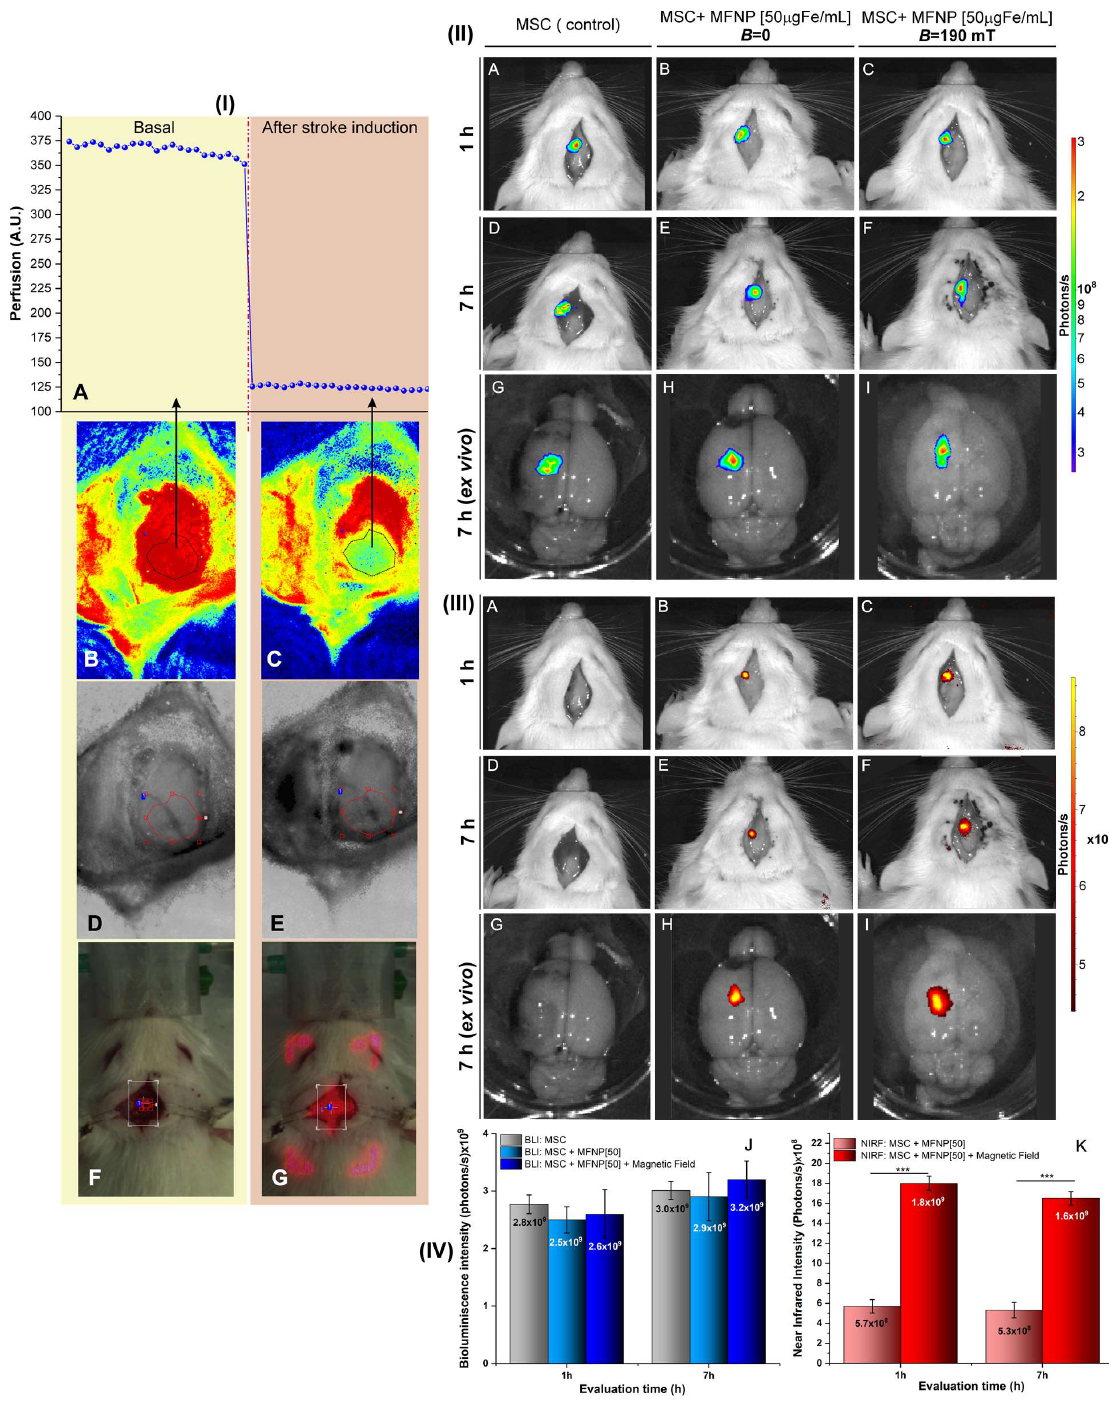
Figure 6. In vivo experiment of the homing of the cell labeled with MFNP by NIRF and BLI images in a focal stroke model. ( I )—Evaluation of ischemic brain lesion by the decreased blood perfusion ( A ), visually shown in the region of interest (ROI), before ( B ), and after ( C ) photothrombotic induction in the median cerebral artery crossing the ROI ( D , E ) through the exposition of a laser to activate the sensitizer dye administrated ( F , G ). ( II )—The comparison of cell homing based on the labeling with the best condition of in vitro experiment with or without submission of a magnetic field by ( II ) BLI and ( III ) NIRF images after 1 h ( A , B , C ), and 7 h of cells implantation ( D , E , F ), then ex vivo images ( G , H , I ). ( IV )—The quantification of the intensity signal of BLI ( J ) and NIRF ( K ) for all conditions analyses according to the time of image acquisition. *** p < 0.001.